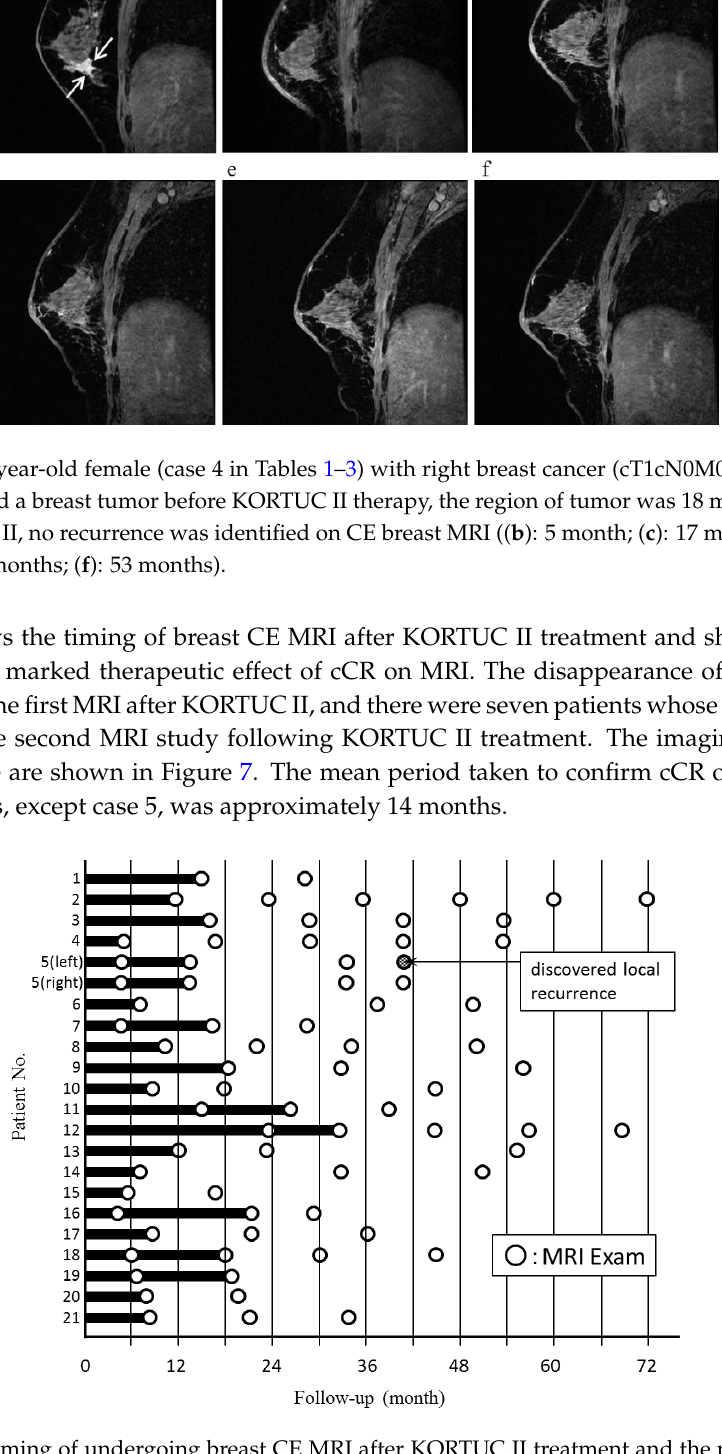
Figure 6. The timing of undergoing breast CE MRI after KORTUC II treatment and the period taken to accept a marked therapeutic effect of cCR on MRI. The mean period of 20 patients except case 5 was approximately 14 months.